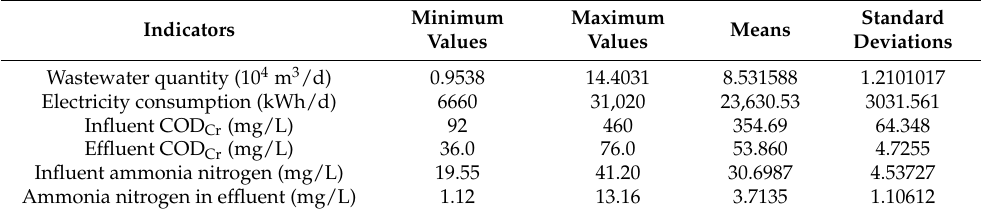
Table 1. Statistics indicators of a wastewater treatment plant in Northeast